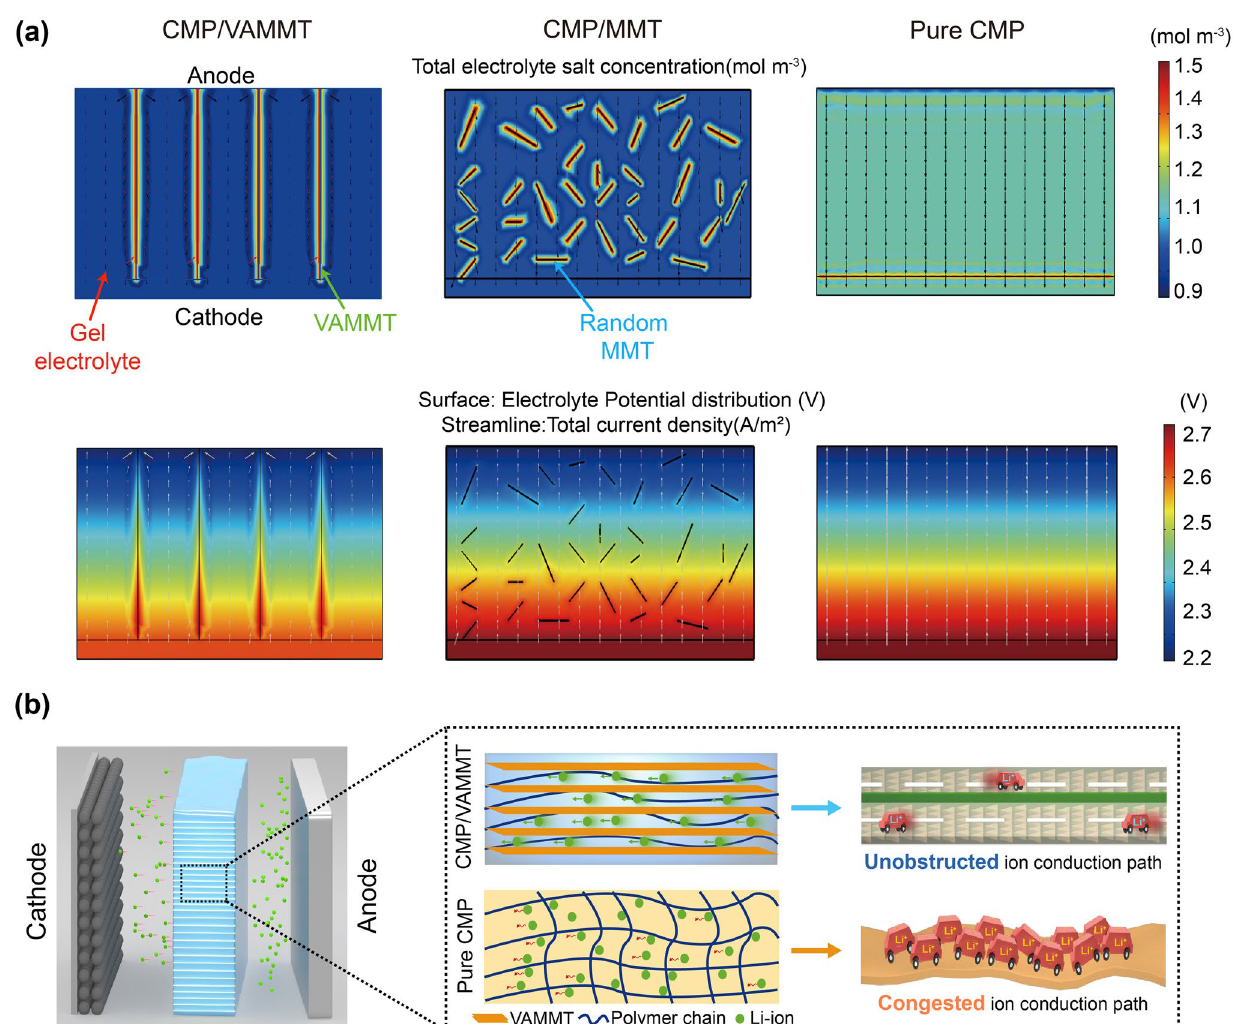
Fig. 5 Li + migration visual analysis. a Modeling total electrolyte salt concentration for the CMP/VAMMT, CMP/MMT, pure CMP (top) and corresponding mapping of electrolyte potential distribution (bottom). b Schematic diagram of CMP/VAMMT in the cell (left) and comparison of Li. + transport between CMP/VAMMT and pure CMP